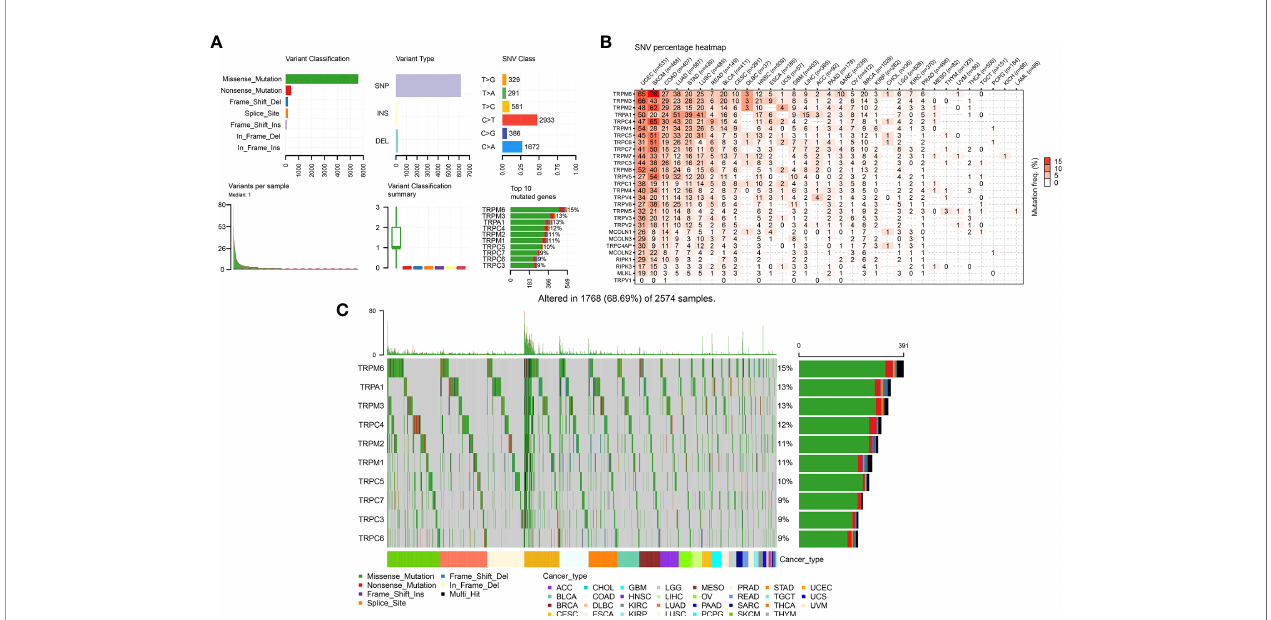
FIGURE 4 | The SNV alteration of TRP family genes in pan-cancer. (A) The information of variant classi fi cation, variant type, SNV class, variants per sample, variant classi fi cation summary, and top 10 mutated genes in pan-cancer. (B) The frequency of deleterious mutations in indicated tumour types. (C) Oncoplot presents the mutation distribution of top 10 mutated genes in pan-cancer.